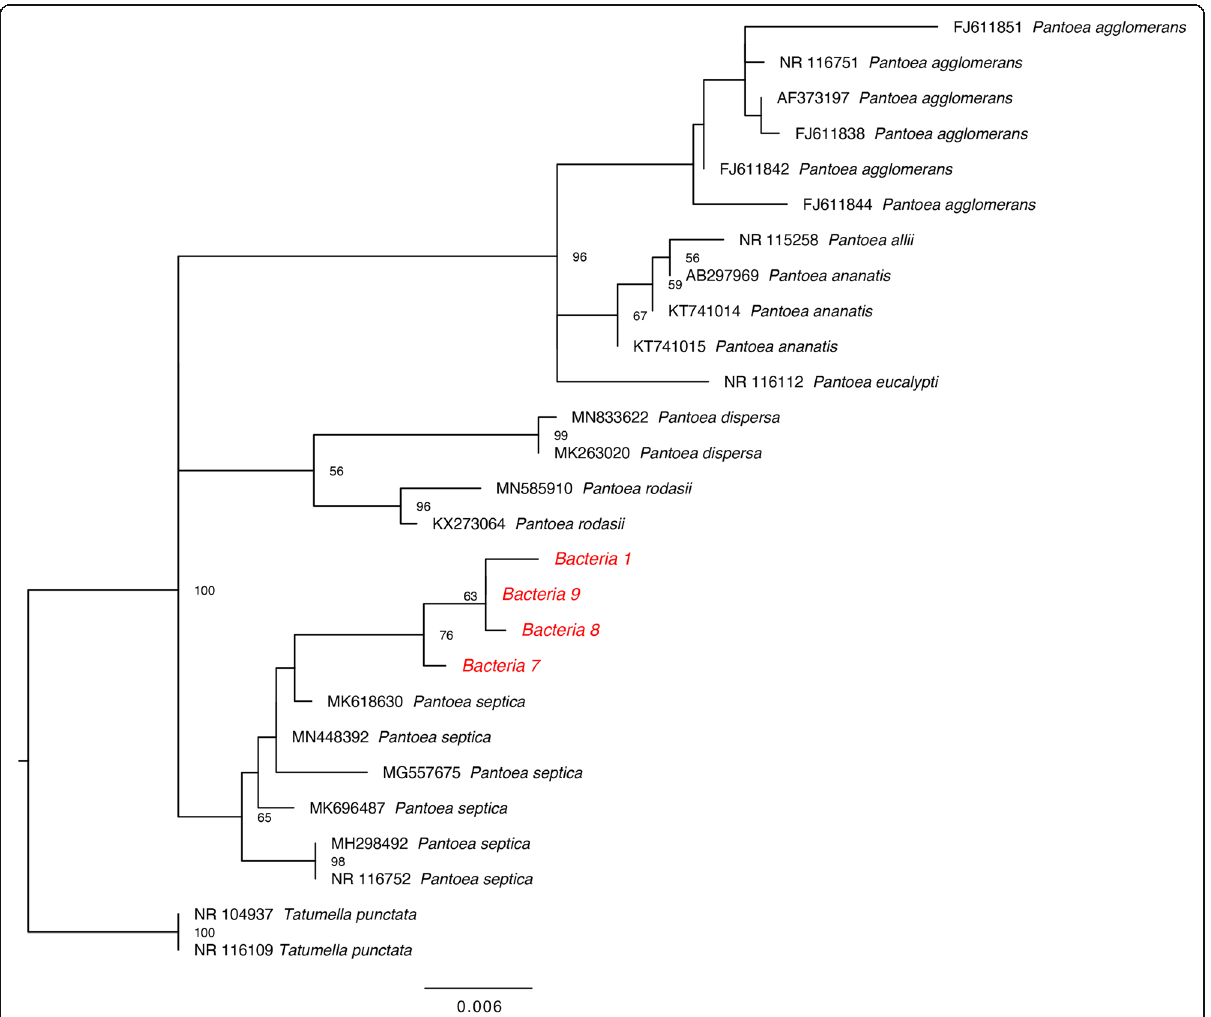
Fig. 1 Phylogram created from ML analysis derives from combined 16S rRNA primers of different bacterial species. The red-coloured isolates are generated from this study. Values above 50 of RAxML bootstrap are stated at the